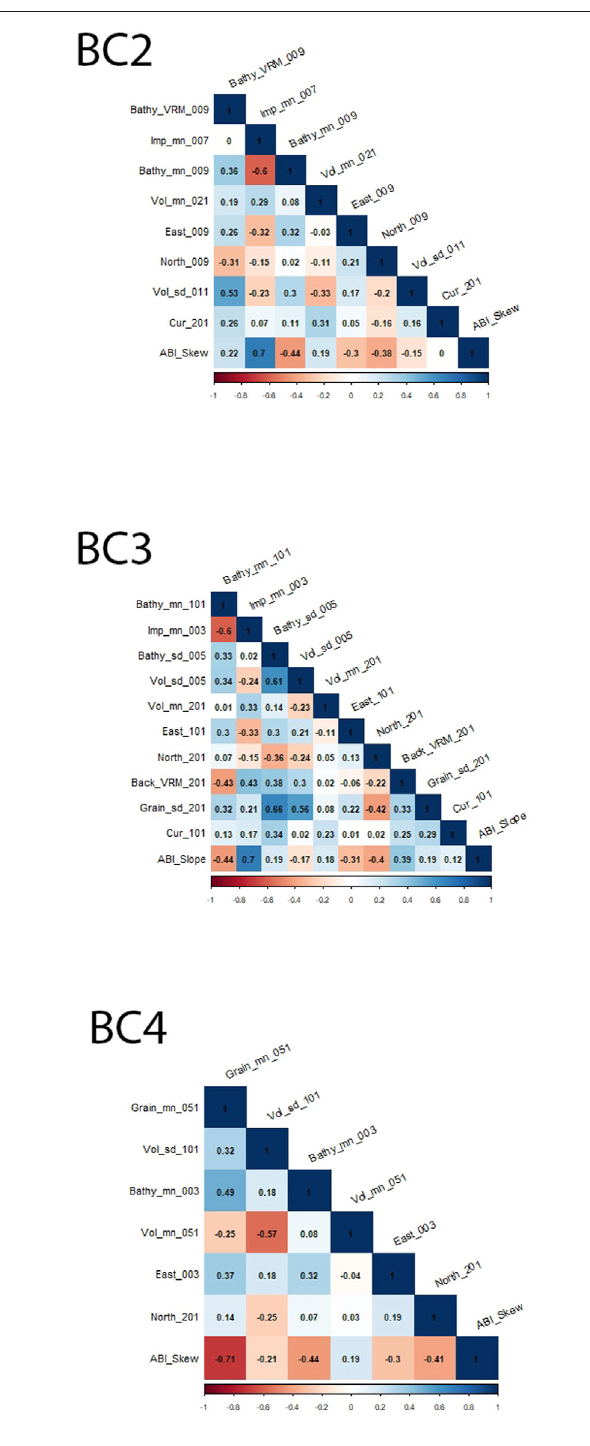
FIGURE 3 | Pearson product-moment correlation plots for fi ne segmentation. See variable code names in Table 3 .